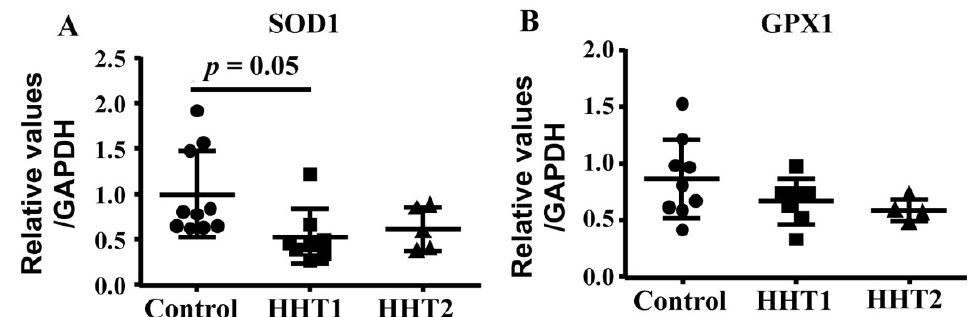
Figure 6. HHT1 MNCs expressed lower levels of SOD1 (superoxide dismutase 1). A. Quantification of SOD1 mRNA. N = 10 for control group; N = 8 for HHT1 group; and N = 5 for HHT2. B. Quantification of GPX1 (glutathione peroxidase 1) mRNA. N = 10 for control group; N = 7 for HHT1 group; and N = 4 for HHT2